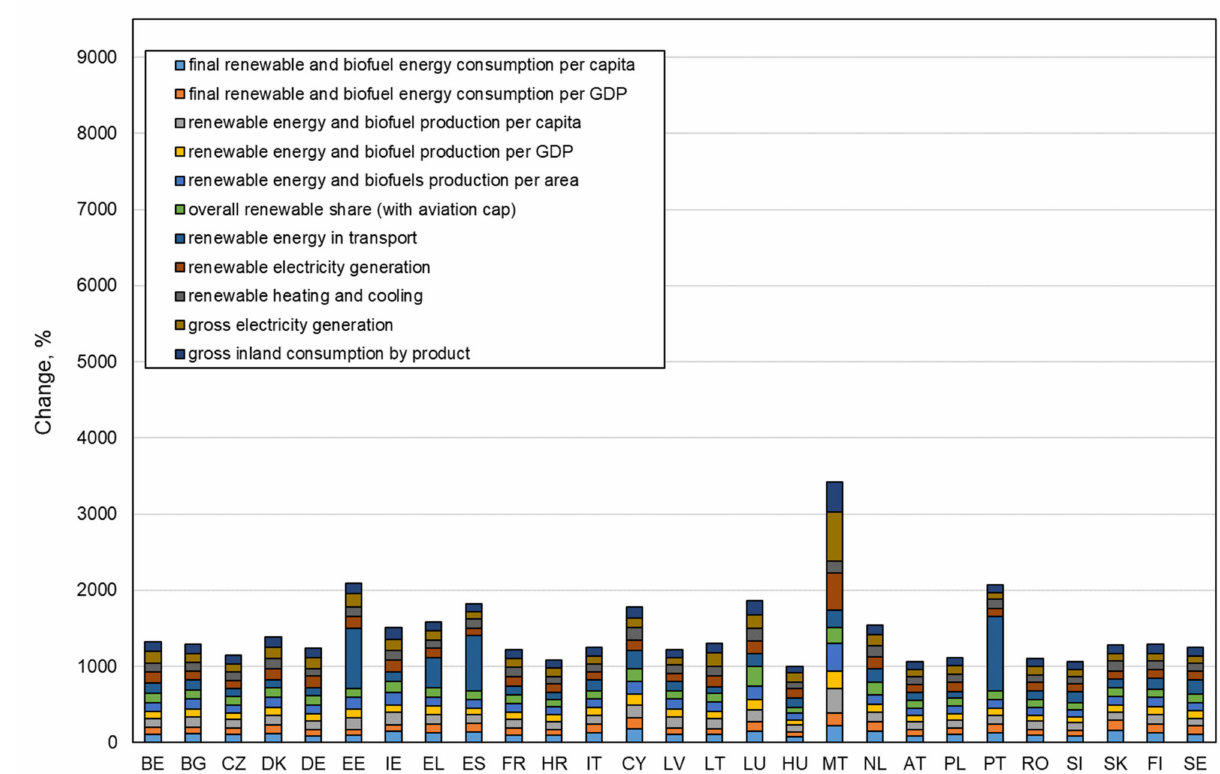
Figure 2. Percentage changes in the values of renewable energy indicators between 2013–2018 in individual EU